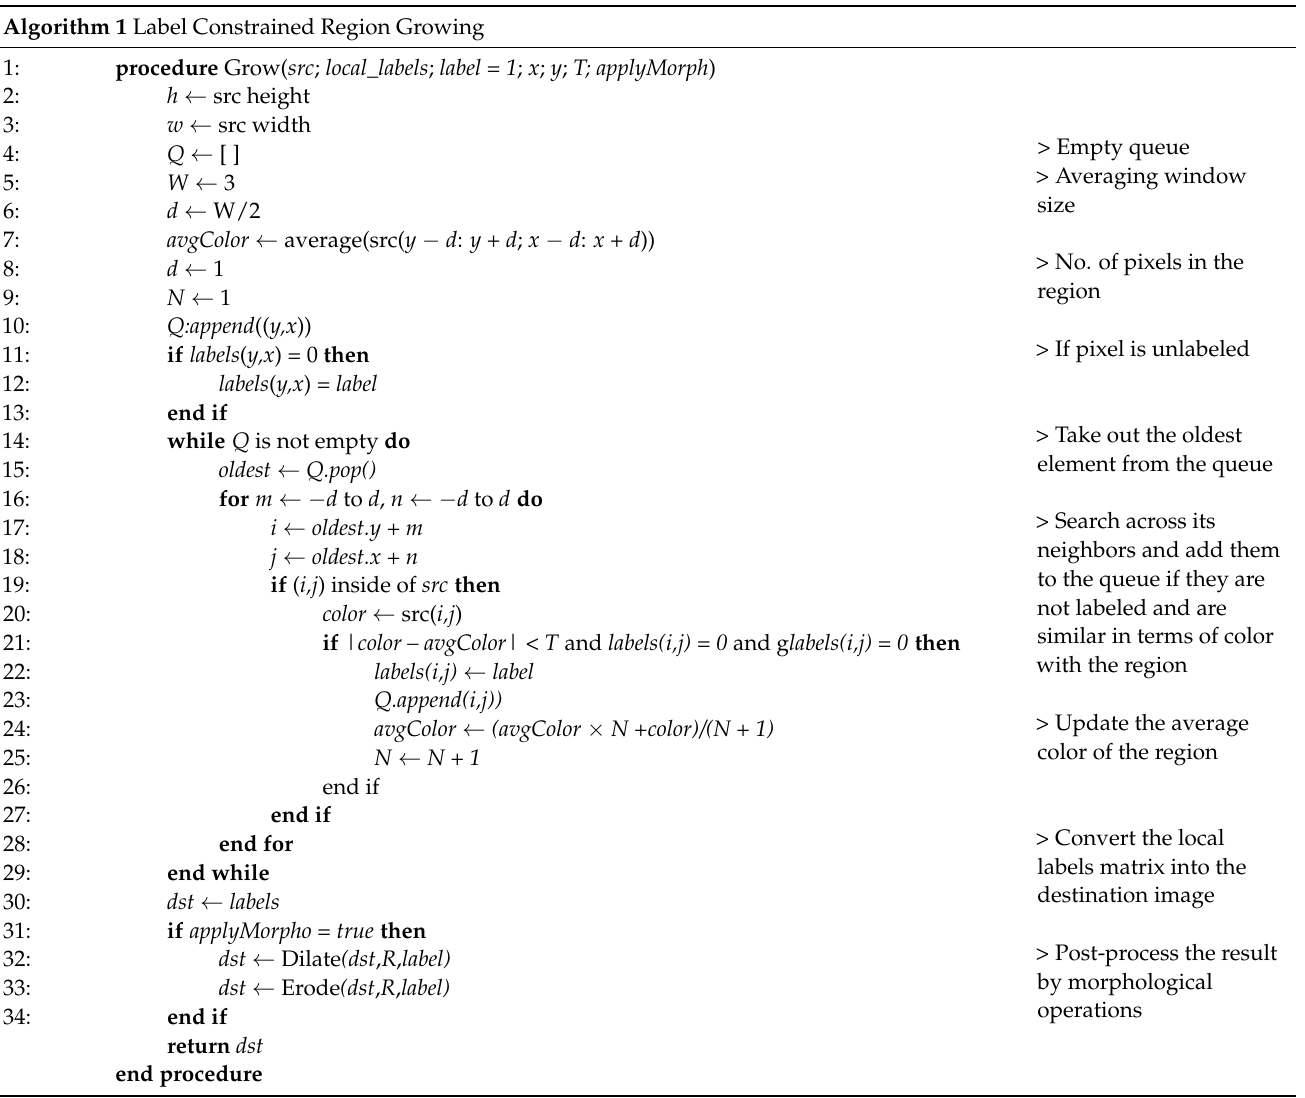
Algorithm 1 Label Constrained Region